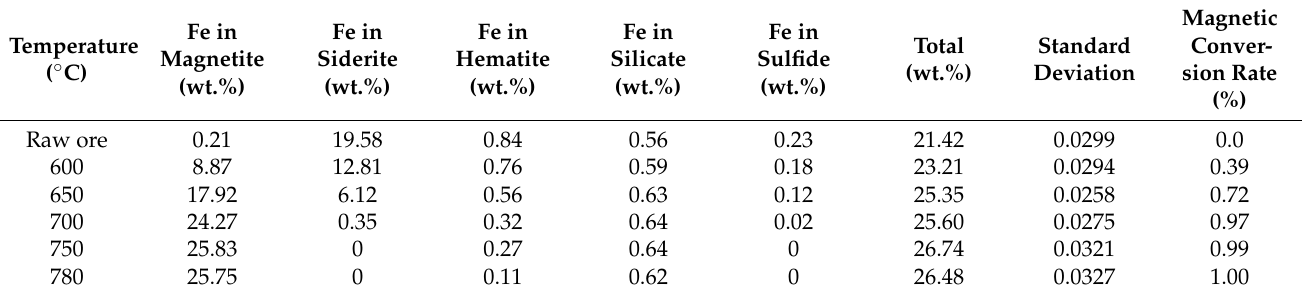
Table 4. Results of the analysis of the iron minerals and magnetic conversion of roasted